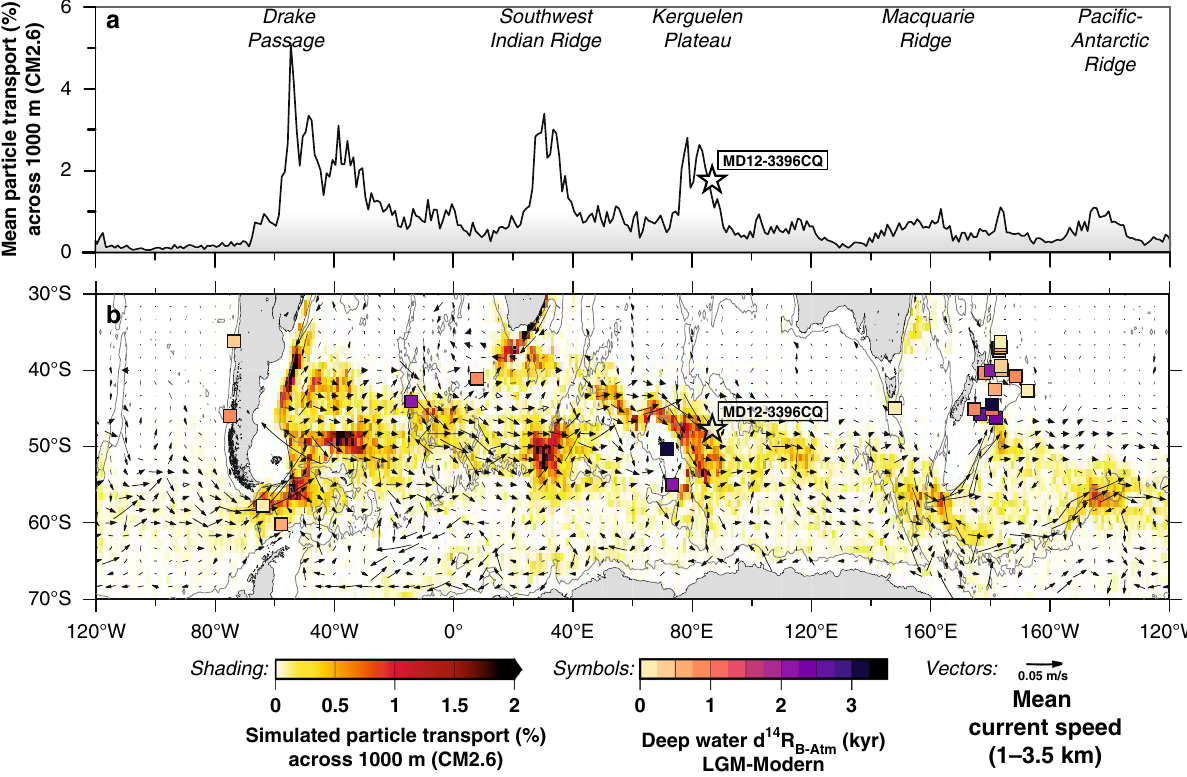
Fig. 2 Regions of intense interaction of the Antarctic Circumpolar Current with local bathymetry in Southern Ocean upwelling hotspots. a Zonal variations in the percentage of upwelling particles transport crossing the 1000-m water depth surface (averaged between 30 – 70°S) as obtained in simulations with the Geophysical Fluid Dynamics Laboratory ’ s Climate Model version 2.6 (CM2.6) 11 , where particles were released between 1 – 3.5 km water depth along 30°S. Increased particle transport in the simulations highlights fi ve major topographic upwelling hotspots in the Southern Ocean 11 . b Spatial changes in particle transport in percent across the 1000 m-depth surface, with vectors showing the average speed and direction of ocean currents at mid-depth (1 – 3.5 km) based on the Global Ocean Data Assimilation System (GODAS) database (https://psl.noaa.gov/data/gridded/data.godas.html) representing the Antarctic Circumpolar Current between 40 – 60°S. Squares indicate reconstructed deep-water 14 C ages in the Southern Ocean during the last glacial maximum (LGM) referenced to preindustrial 10,16 . Star in both panels shows the location of the study core. Figure modi fi ed after ref. 11